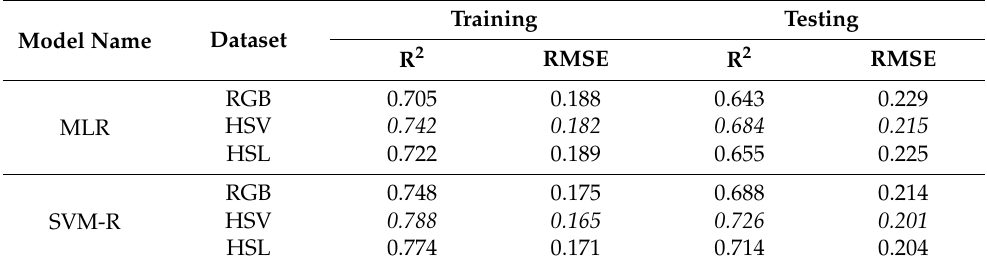
Table 6. Performance metrics (R 2 and RMSE) of the models for predicting the pH of strawberry fruits during the testing and training period. The values in italics indicate the best results in each model among the three colour